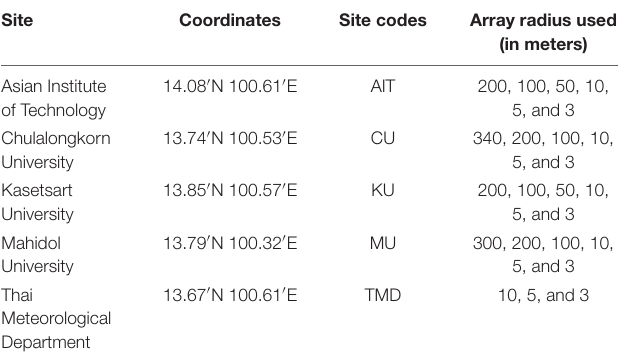
TABLE 1 | Details of the seismic survey sites.